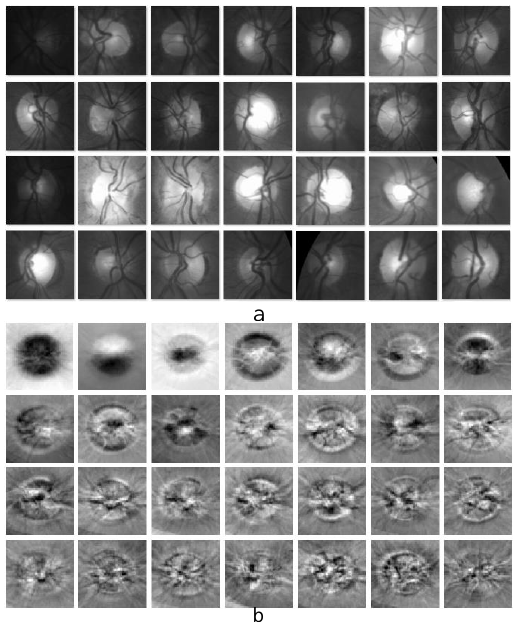
Figure 4. a) The set of the cropped optic discs from HEI-MED database , b) The first 28 corresponding PCs. To detect the position of the optic disk in a